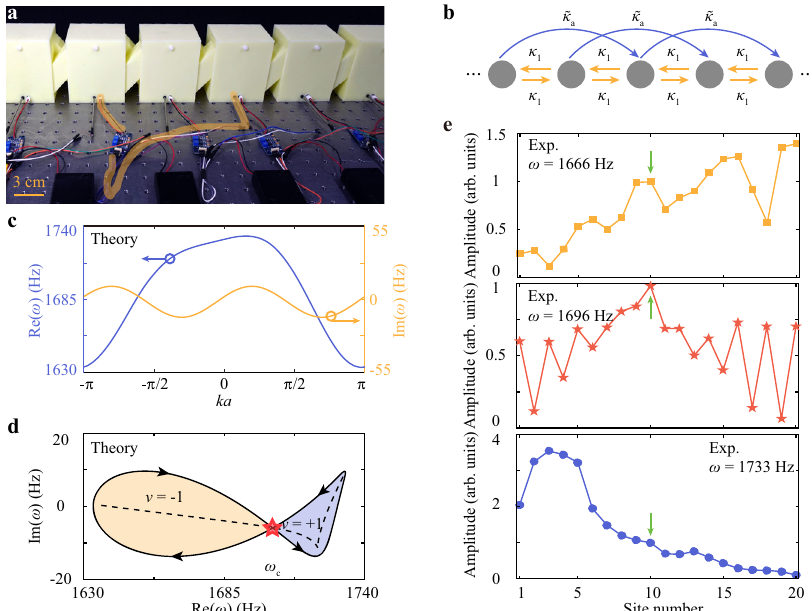
Fig. 4 Observation of acoustic NHSE from twisted-winding topology. a Photograph of the experimental setup, where the acoustic ampli fi ers connect the next-nearest-neighbor resonators. The yellow curve highlights an ampli fi er providing the non-reciprocal next-nearest-neighbor coupling. b Tight-binding model with reciprocal nearest-neighbor coupling κ 1 and non-reciprocal next-nearest-neighbor coupling ~ κ a . c Real and imaginary parts of the eigenfrequency spectrum calculated with periodic boundary conditions. d The complex eigenfrequency spectrum calculated in ( c ) forms a twisted winding with two opposite oriented loops in contact. The left loop takes the winding number v = − 1, while the right one takes v = + 1. The contact point, denoted as a red star, is the Bloch point. The dashed line corresponds to the eigenfrequency spectrum calculated with the open boundary conditions. e Measured fi eld distributions when the source is fi xed at site 10, but the frequency increases from ω = 1666, 1696, 1733 Hz. The measured results are normalized by the amplitude at the source location (indicated by little